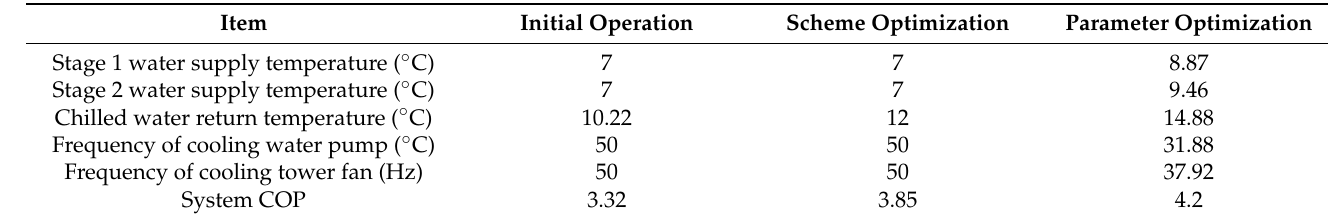
Table 4. Operating parameters and system COP under optimization